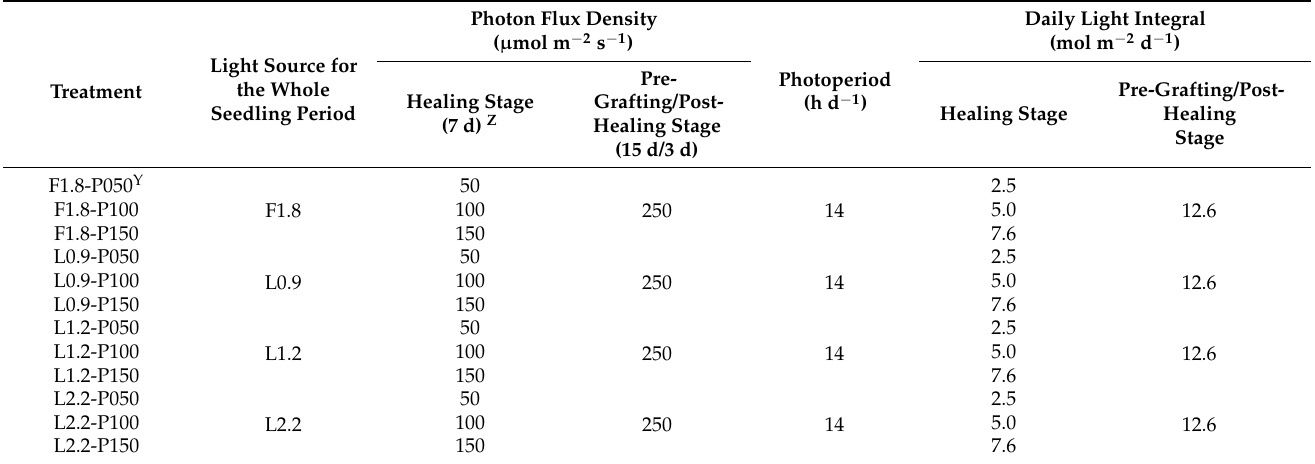
Table 1. Lighting treatments created by four kinds of light sources during the whole seedling period and three levels of photon flux density in the healing stage.